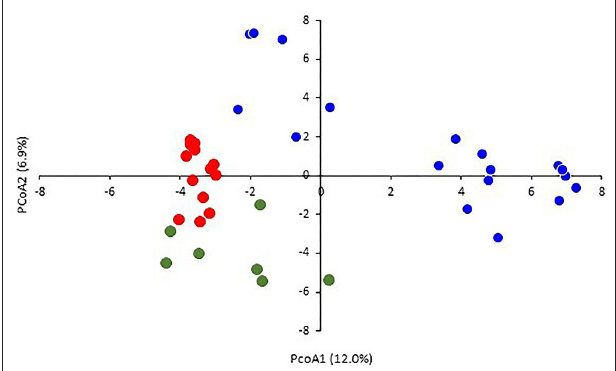
FIGURE 3 | Principal coordinate analysis (PCoA) based on the genetic distances for durum wheats using 5,555 SNPs. The samples are colored in blue (modern durum cultivars, MDC), red (Tunisian durum landraces group 1, TDL-1), and green (Tunisian durum landraces group 2, TDL-2).